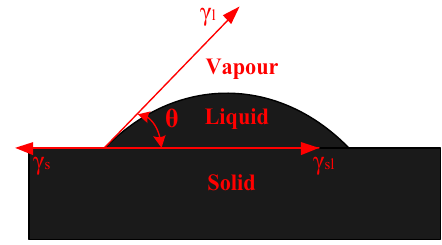
Figure 7 Schematic diagram of contact